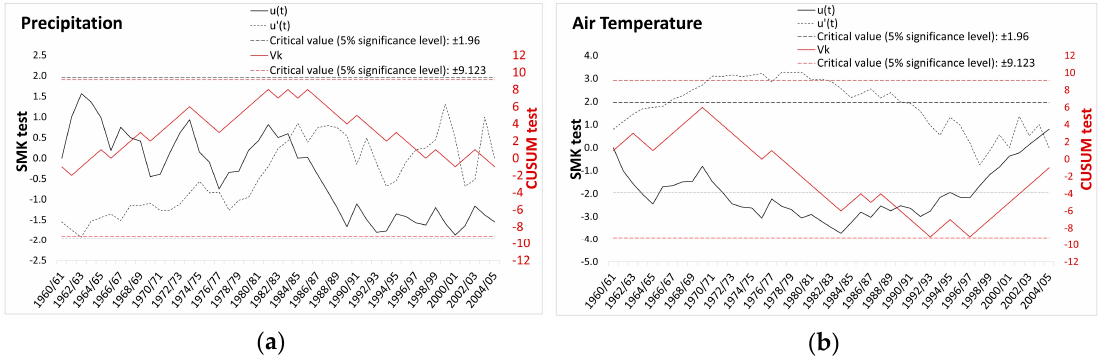
Figure 10. SMK and CUSUM tests for ( a ) precipitation and ( b ) air temperature.